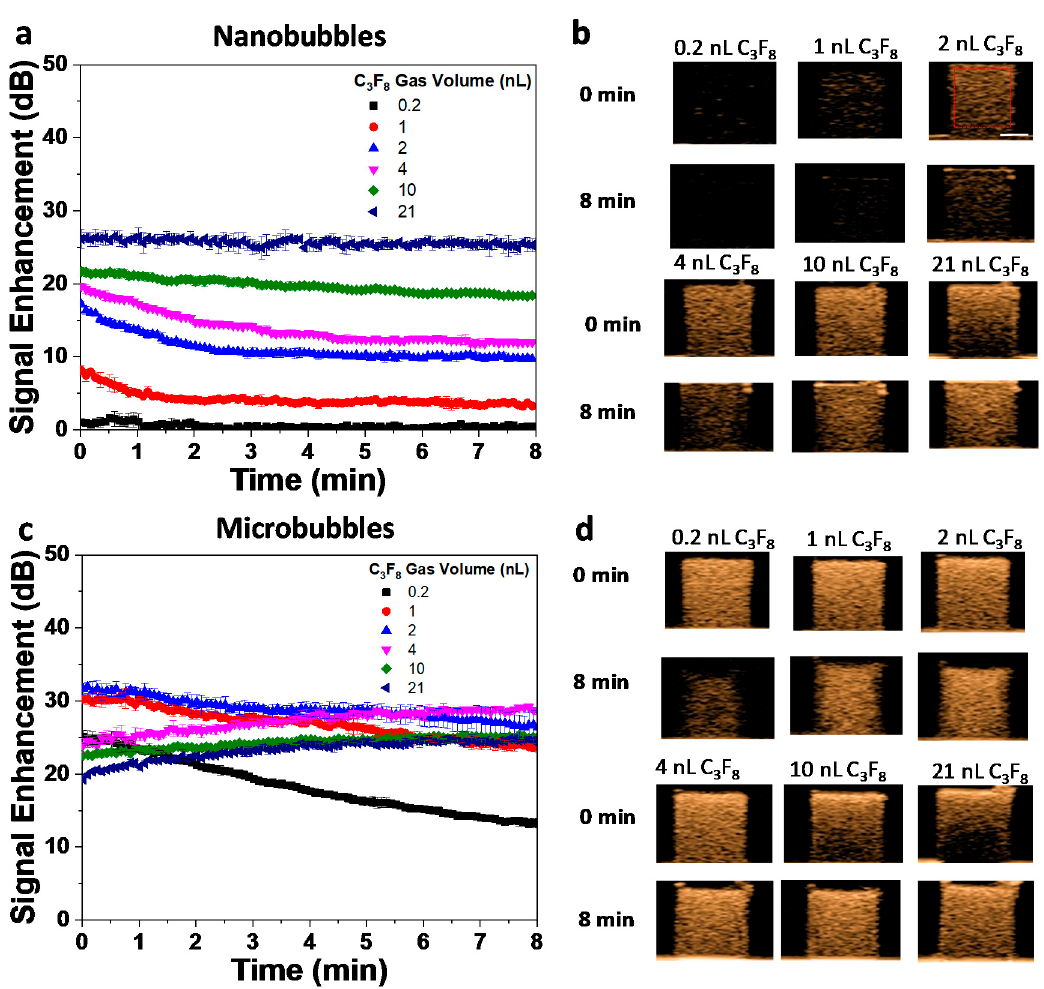
Figure 4. Stability under exposure to ultrasound (f: 12 MHz, MI: 0.1, and frame rate: 1 fps) of the as-prepared bubbles was evaluated at different C 3 F 8 gas volume concentrations for ( a , b ) nanobubbles and ( c , d ) microbubbles. The open square in red (b, 2 nL C 3 F 8 ) shows a representative region of interest (ROI) used to analyze the time intensity curves. Representative scale bar (b, 2 nL C 3 F 8 ) for all the images: 2 mm.